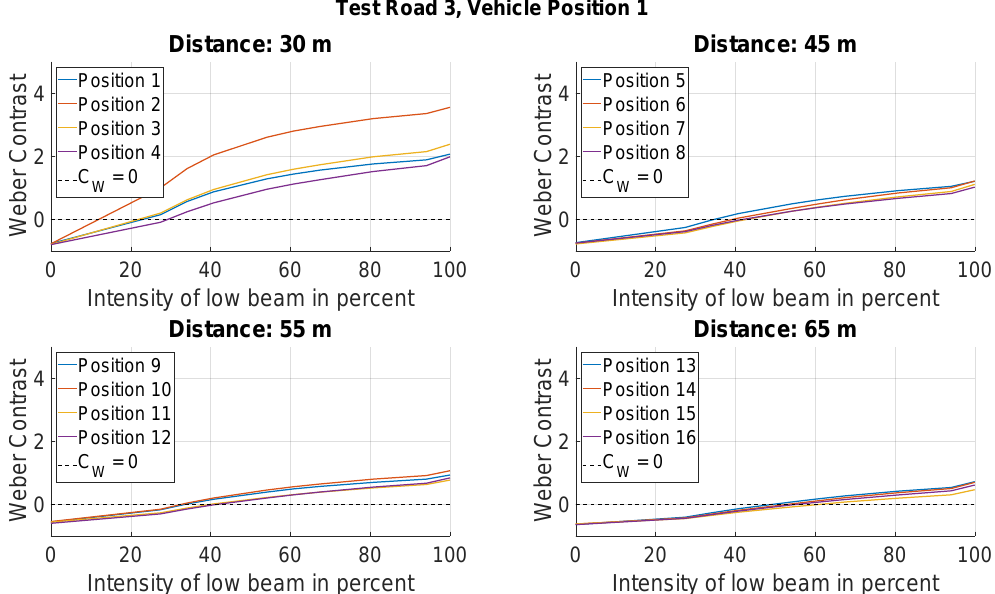
Figure 8. Contrast curves on test road 3 (0.38cdm − 2 ) and vehicle position 1 depending on the intensity percentage from 0% (low beam off) to 100% (low beam fully switched on).